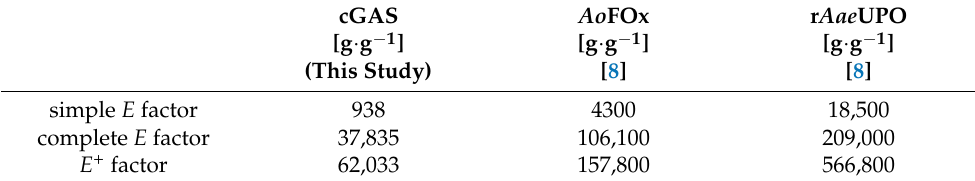
Table 2. Calculated E factors for the production and purification of cGAS. The E factors for the enzymes r Aae UPO, which was expressed with Pichia pastoris, and Ao FOx, which was expressed in E. coli at lab scale (13 L bioreactor), are also listed as a reference [8]. The simple E factor includes the used chemicals. The complete E factor additionally considers water required for the production and purification. The E + factor also includes the CO 2 emissions caused by the energy consumption during production.